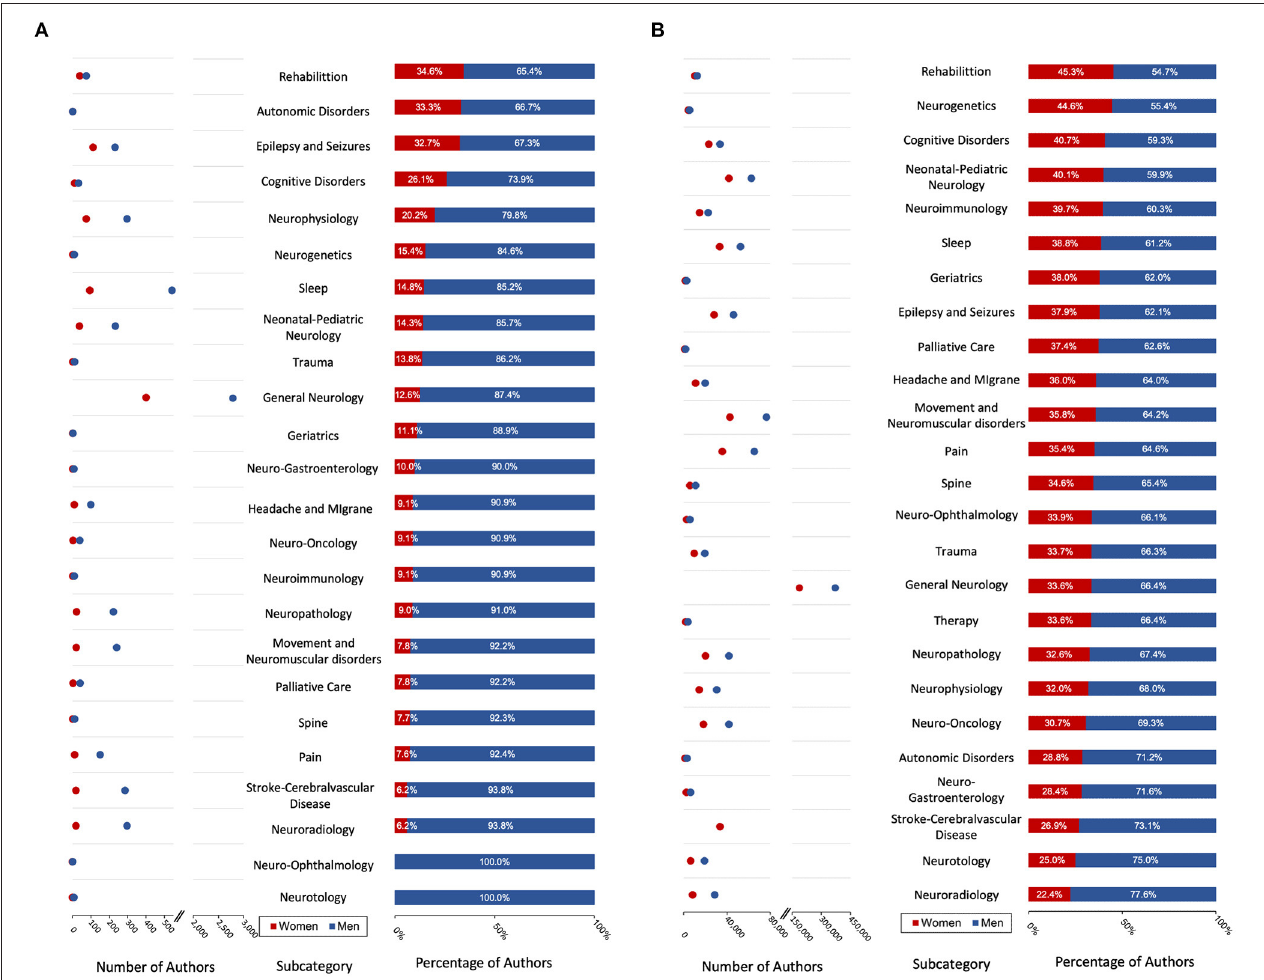
FIGURE 4 | Gender authorship distribution by journal categories. (A) From 1946 to 2001 and (B) From 2002 to 2020. Left points indicate number of authors in each category. Bars indicate proportion. Categories are ordered by proportion of women authors.